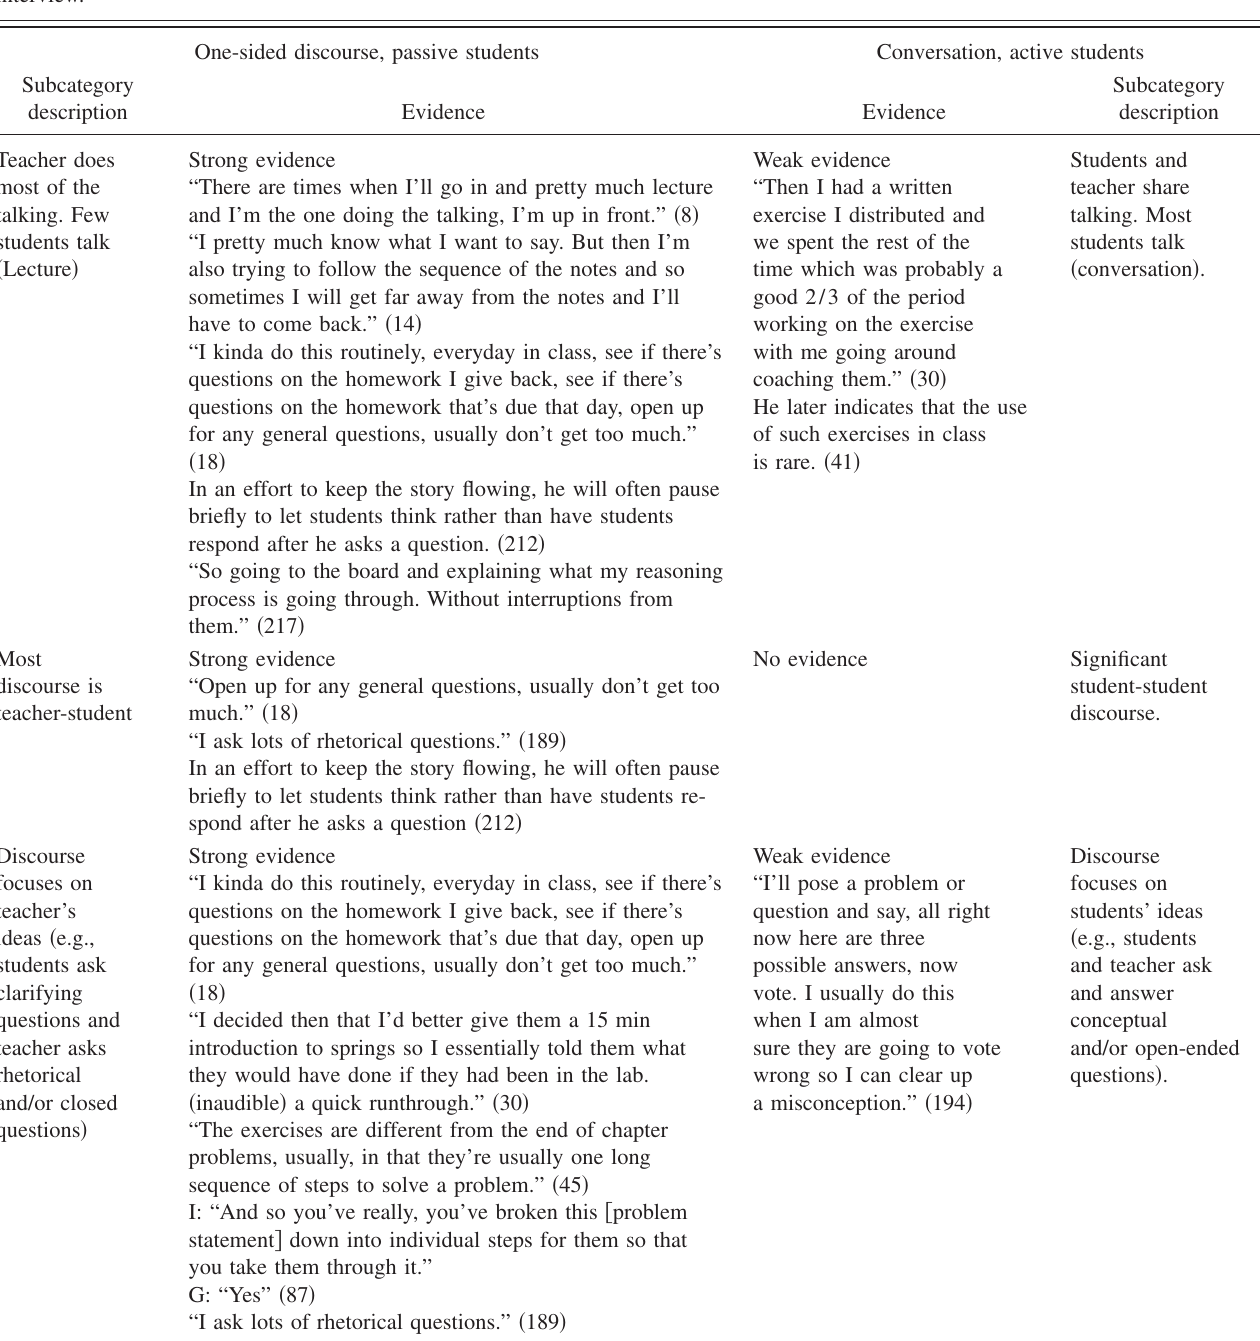
TABLE III. Example of analysis. Evidence collected from Gary’s interview related to the interactivity category of instructional practices (cid:1) P1 (cid:2) . An assessment of the strength of available evidence is provided at the beginning of each cell. Numbers in parentheses indicate line numbers in the interview. Thus, a variety of well-separated numbers in a particular category shows that evidence was collected from multiple parts of the interview, while only one number, or a set of nearby numbers, suggests that evidence was collected from only one part of the